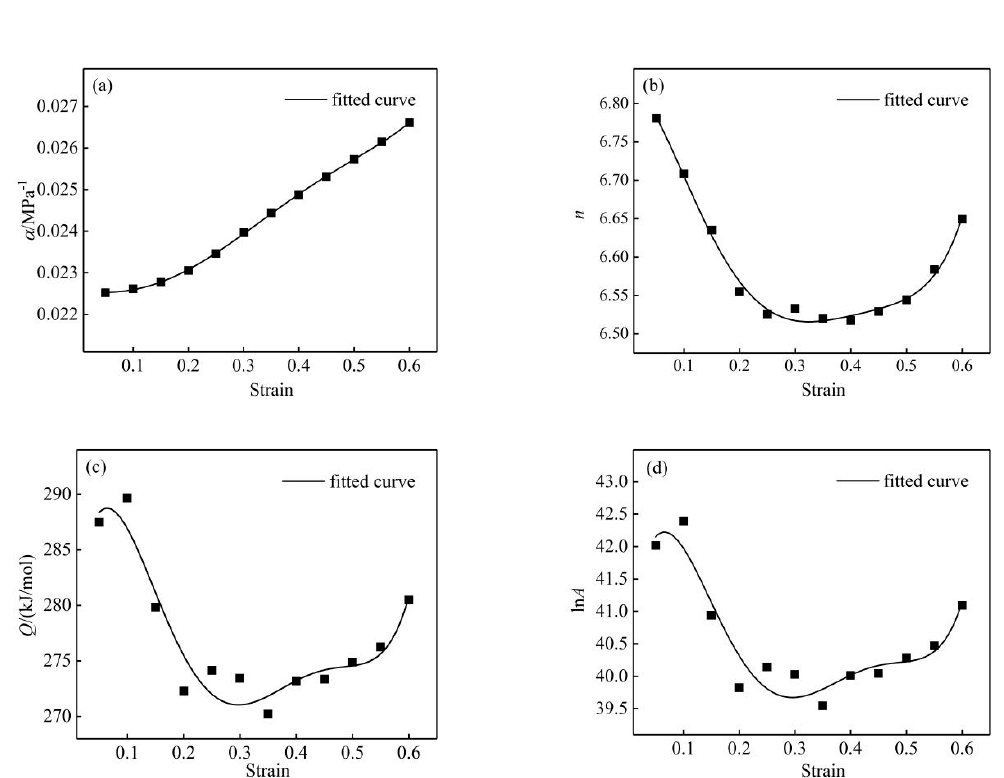
Figure 7. Relationships between true strain and material constants: ( a ) α - ε ; ( b ) n- ε ; ( c ) Q- ε ; ( d ) lnA- ε . Table 2. Coe ffi cients of α , n, lnA, and Q in Equation